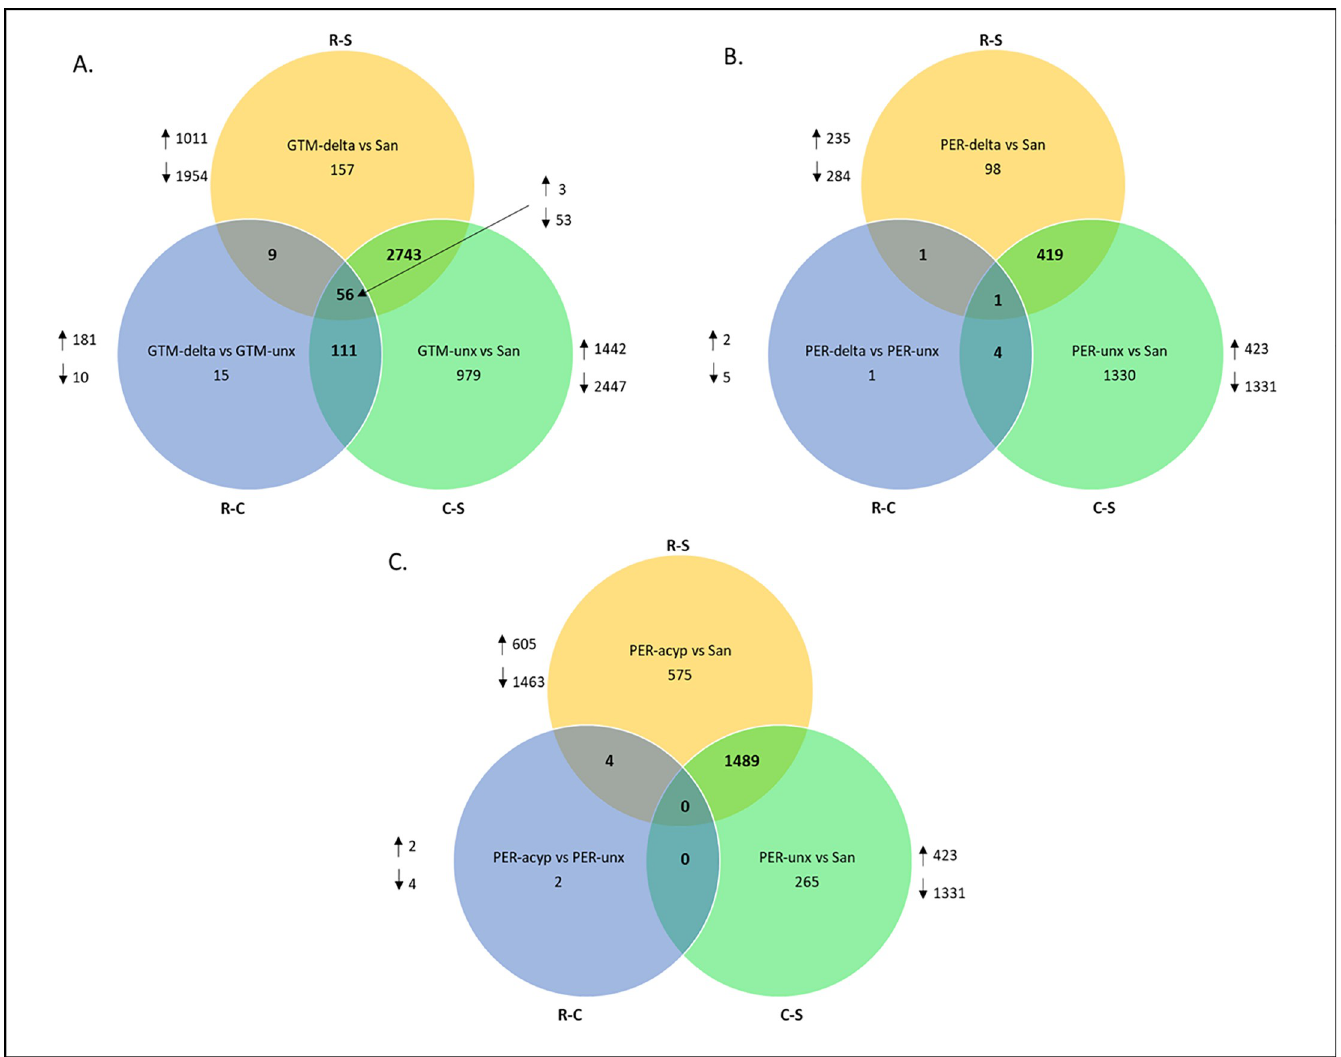
Fig 3. Venn diagrams summarizing the numbers of differentially expressed (DE) genes between resistant (R), unexposed (C) and susceptible (S) samples with a transcription ratio � 2 fold change in either direction and a corrected p value < 0.05. A.) DE genes in the Guatemala deltamethrin resistant samples; B.) DE genes in the Peru deltamethrin resistant samples; C.) DE genes in the Peru alpha-cypermethrin samples.